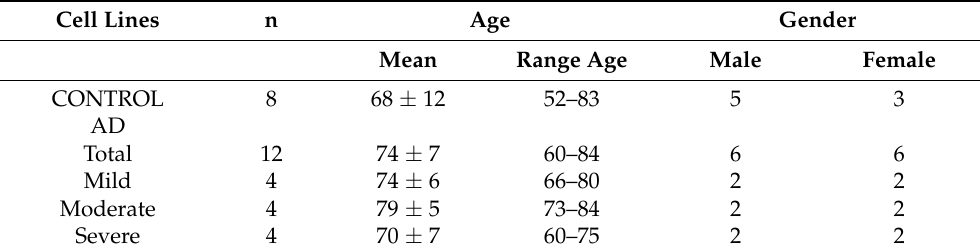
Table 2. Summary data of the study